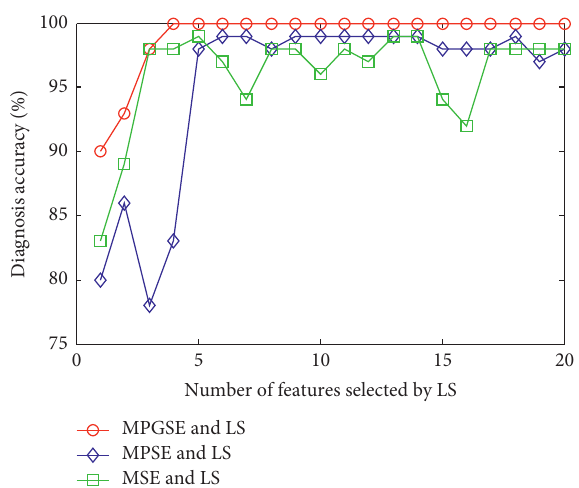
Figure 23: Diagnostic accuracy of three methods under different feature dimension in case 1. Table 8: Diagnostic results of different methods with LS feature selection for the B dataset and C dataset in case 1. Dataset